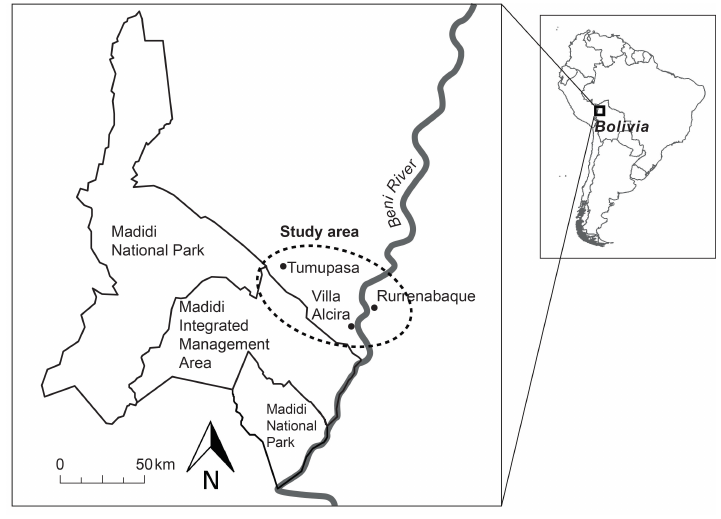
Figure 1. Location of study sites in Bolivia (source: authors, data: